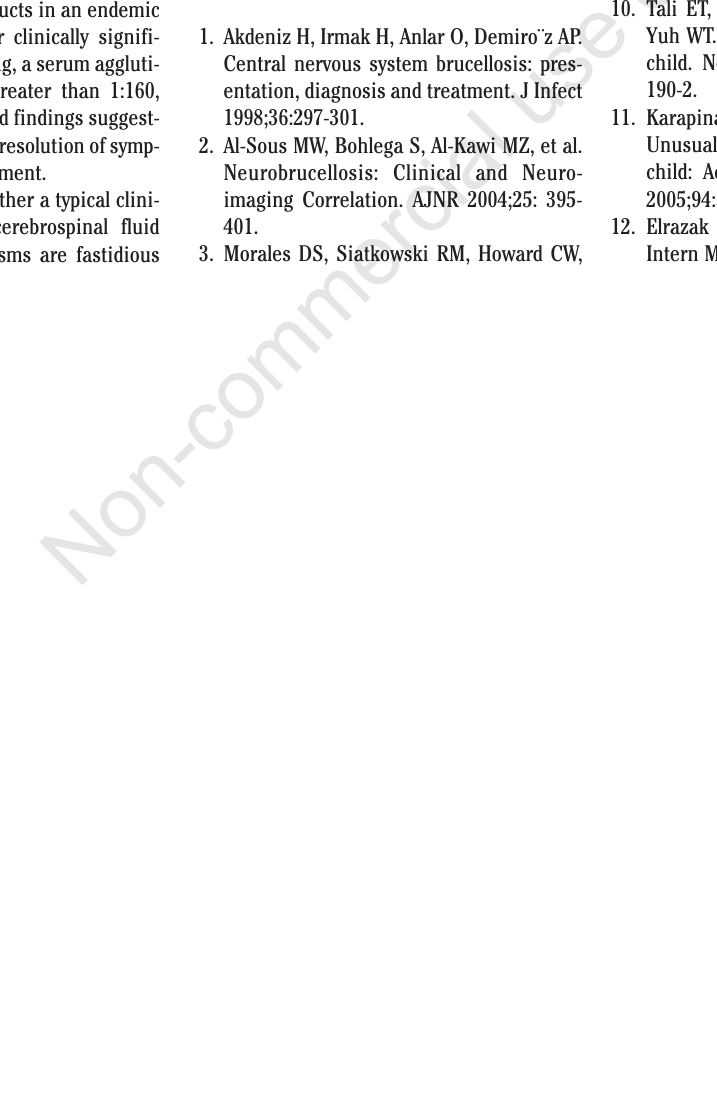
Table 1. Treatment of acute brucellosis in adults and children older than 8 years, World Health Organization (WHO) guidelines recom- mend rifampin (600-900 mg) and doxycycline (200 mg) daily for a minimum of 6 weeks. Duration of therapy is controverse. We have chosen a 6 month therapy, as we were con- cerned on the possibility of relapse, especially if treatment is short.